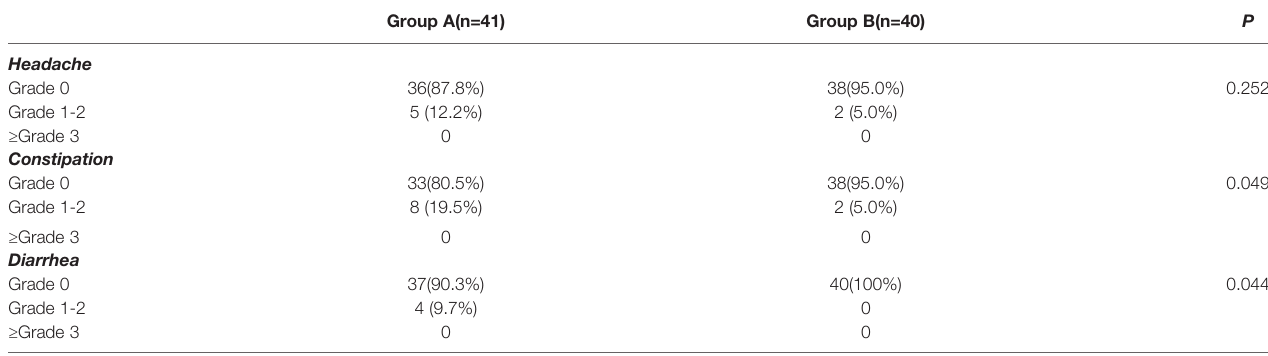
TABLE 4 | The grade of the adverse events.